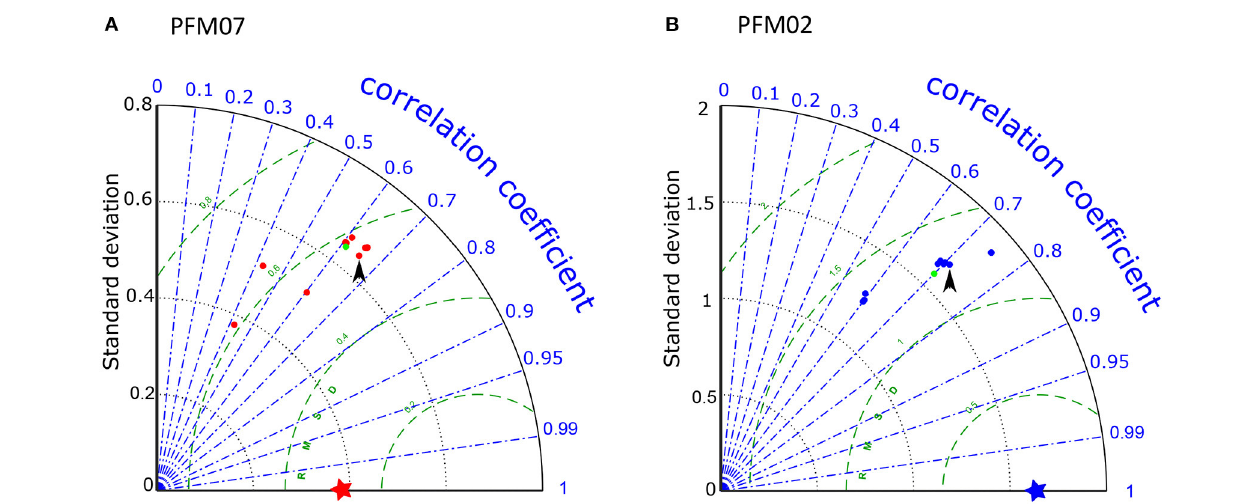
FIGURE 5 | Taylor diagrams for the model skill assessment of the sensitivity analysis at (A) station PFM07 in red dots and (B) station PFM02 in blue dots. Corresponding observations are depicted as star in respective colours at each plot. The best fit model-observation in the sensitivity analysis is indicated by the black arrows. For a comparison, results adopting parameters from Aley17 are shown in green